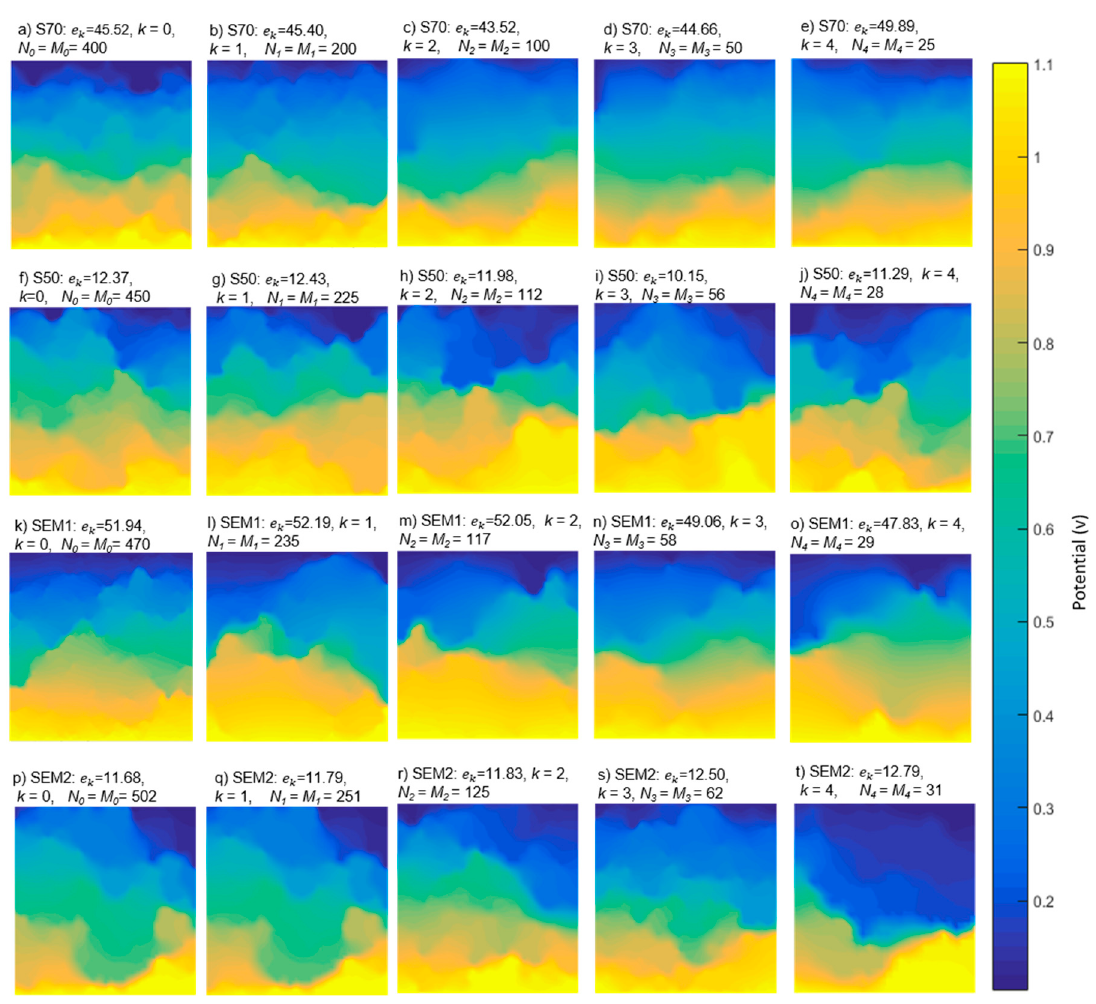
Figure 6. Potential distribution (V) of the electronic conduction phase of some reconstructed